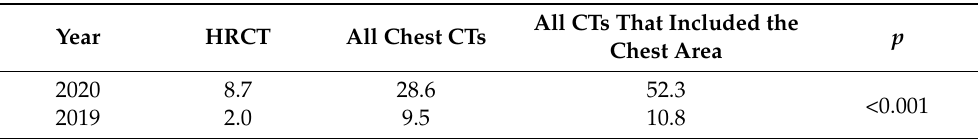
Table 2. The number of chest CT examinations per 1000 patients performed in 2019 and during the COVID-19 pandemic in 2020. The years are presented in descending order. Year HRCT All Chest CTs